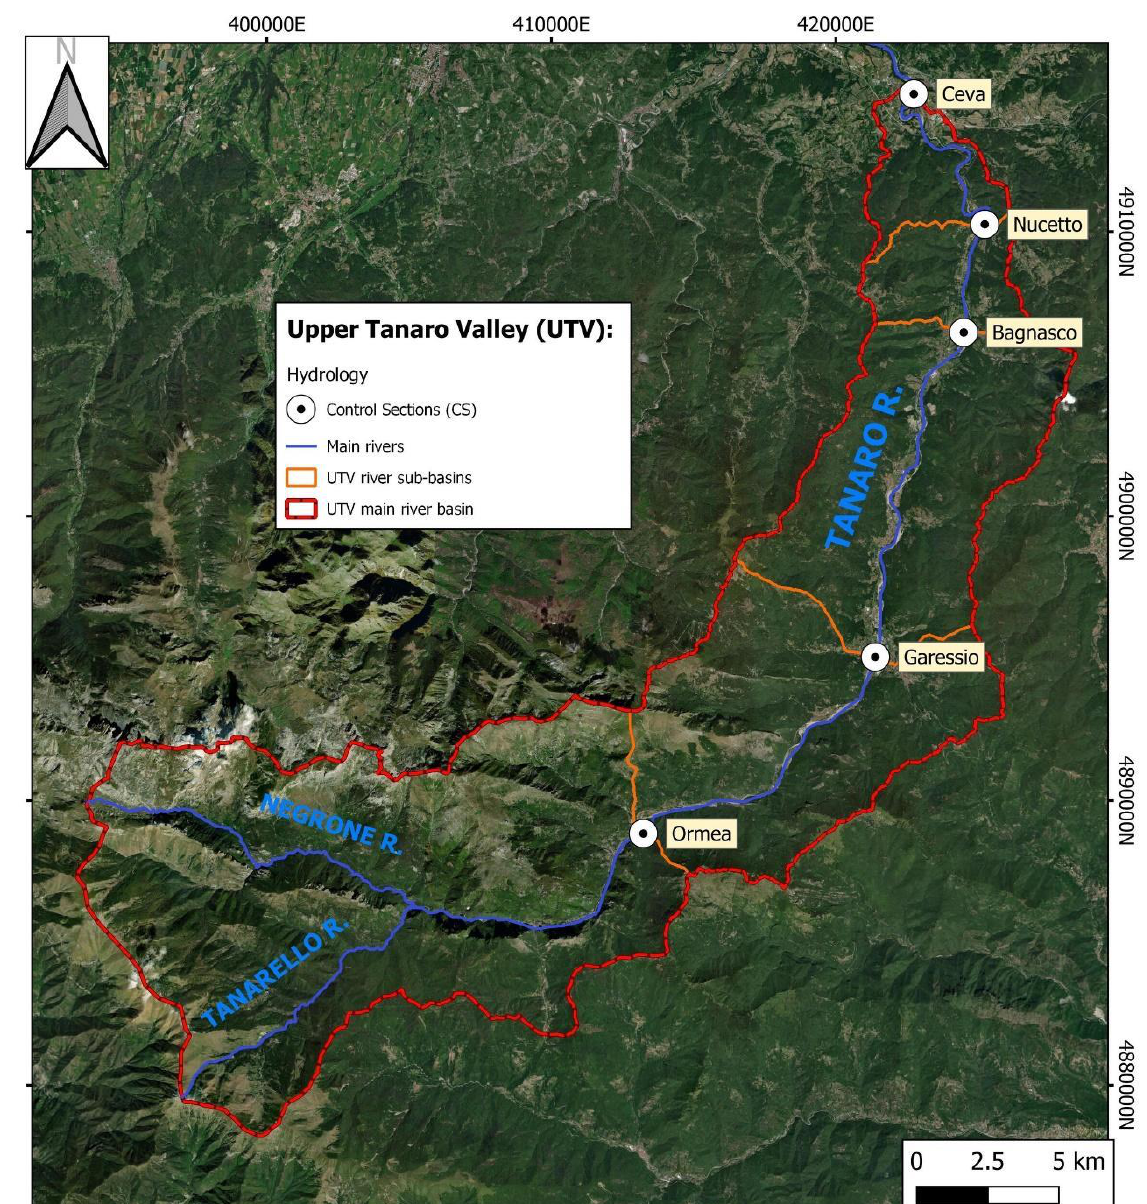
Figure 11. The five control sections located in the UTV main urban areas and the sub-basins they define. By calculating the area of a triangle representing the ideal flood hydrograph, the equivalent maximum expected volume of floodwater for the position of the two dams along the Negrone and Tanarello rivers is evaluated, considering the expected rainfall intensity assessed at each of the five control positions along the Tanaro River: results are shown in Table 5. Then, the height of the dams for both selected positions able to contain the flood water volume is determined: for the dam positioned on the Negrone River, its optimal height is equal to 63 m, while for the dam on the Tanarello River it is 34 m. This is the OS, which allows only 10% of the maximum entering water flow rate and represents the best possible risk mitigation scenario: the outgoing water flow rate for the dam on the Negrone River is equal to 21 m 3 /s, and to 17 m 3 /s for the dam on the Tanarello River. By comparing the values of the water flow rate at the five control positions with and without the dams in this configuration, the mitigation effect can be appreciated (Table